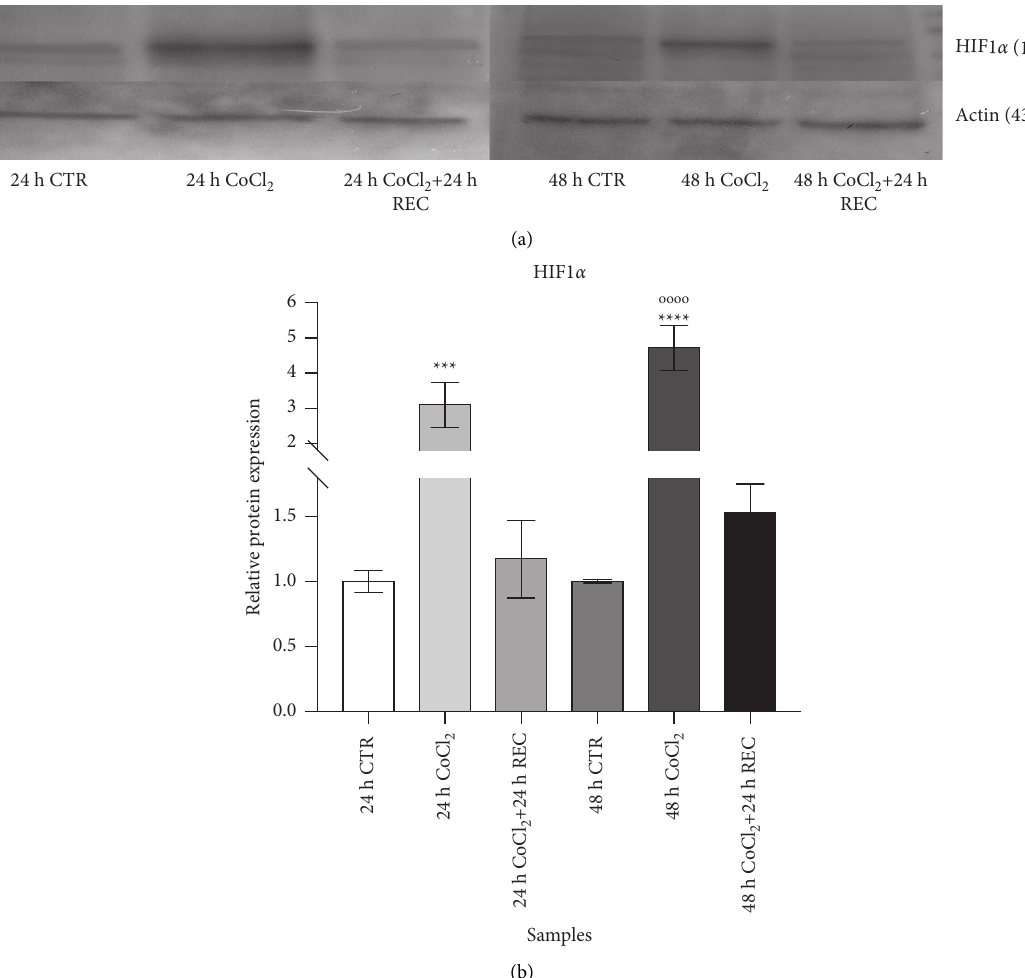
Figure 3: Analysis of HIF-1 α and β -actin protein expression levels by western blot evaluated in MIO-M1 cells at different time points of treatment. (a) Representative immunoreactive bands for HIF-1 α (top; 120kDa) and β -actin (bottom; 43kDa). For each sample, 200 μ g of protein was loaded on SDS-8% polyacrylamide gel. (b) Relative expression of HIF-1 α protein, normalized to the respective β -actin, is represented as mean ± SD of three repeated experiments. ∗∗∗ p < 0.001 (24h CoCl 2 vs. 24h CTR); ∗∗∗∗ p < 0.0001 (48 h CoCl 2 vs. 24h CTR); and p < 0.0001 (48h CoCl 2 vs. 48 h CTR) by one-way ANOVA and Tukey’s post hoc